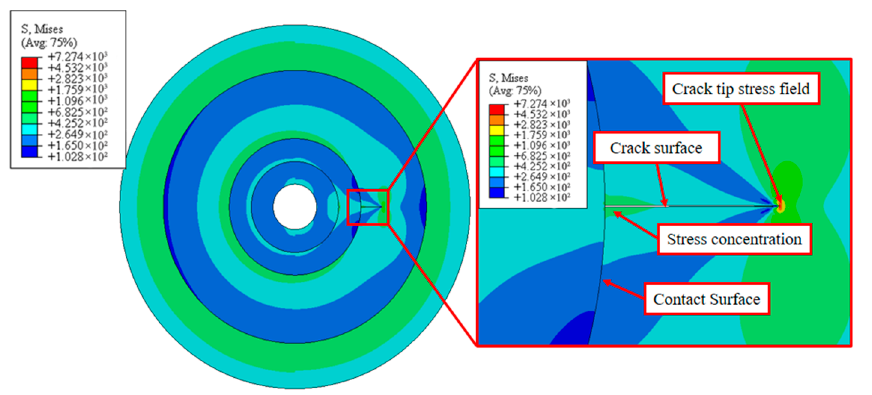
Figure 9. 2D finite element model. ( a ) The 2D plane model consists of thick-walled cylinders with four-layers under interference fit. ( b ) The model applies the boundary conditions.